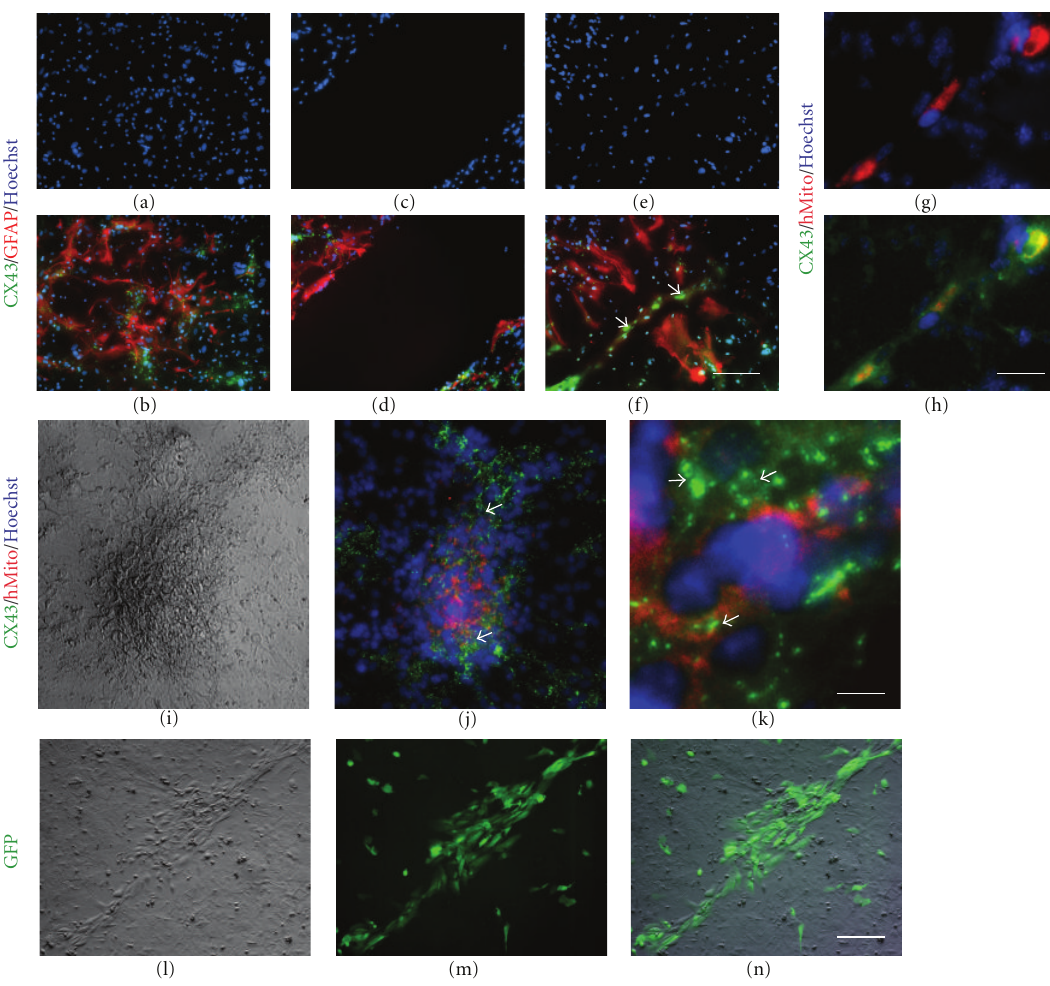
Figure 6: AF cells repair the scratch-induced wound injury in cortical cultures. (a)-(b) A low magnification of confluent cortical cultures stained with Hoechst (a and b, blue), GFAP (b, red) and Cx43 (b, green). (c)-(d) Parallel cortical cultures were subjected to scratch injury and stained with the same markers 24 hrs later. GFAP positive astrocytes were seen at the scratch border (d), without repairing the wound. (e)-(f) In contrast, when AF cells were seeded following scratch, they filled the injury site (f, arrows), maintained CX43 expression (f, green), and facilitated wound repair. (g)–(k) To further identify AF cells located in the injury site, separate cultures were stained with human mitochondrial marker (red), CX43 (green), and Hoechst counter stain (blue). Cx43 was readily expressed at the boundary between AF cells and cortical cells (k). (l)–(n) Live assays, using GFP-tagged AF cells, were also used to confirm wound repair after scratch injury in cortical cultures. Scale bar: 150 μ m (a)–(f), 35 μ m (g)-(h), 90 μ m (I, J), 10 μ m (k), 80 μ m